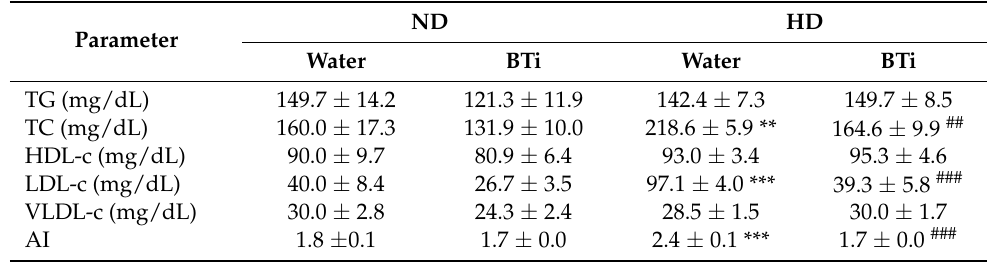
Table 3. Effect of the BTi on the mice lipid profile.